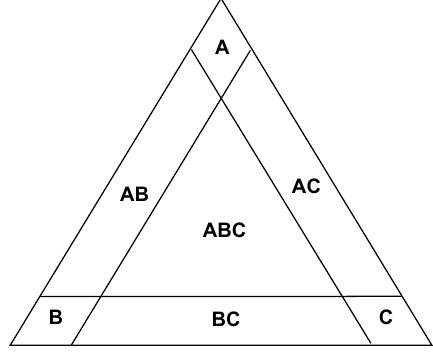
Fig. 1. Compositional categories for a ternary aerosol